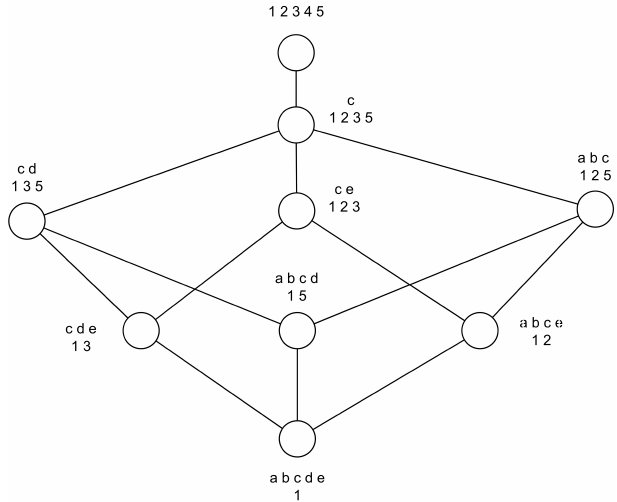
Figure 3. Concept lattice of the formal context in Table